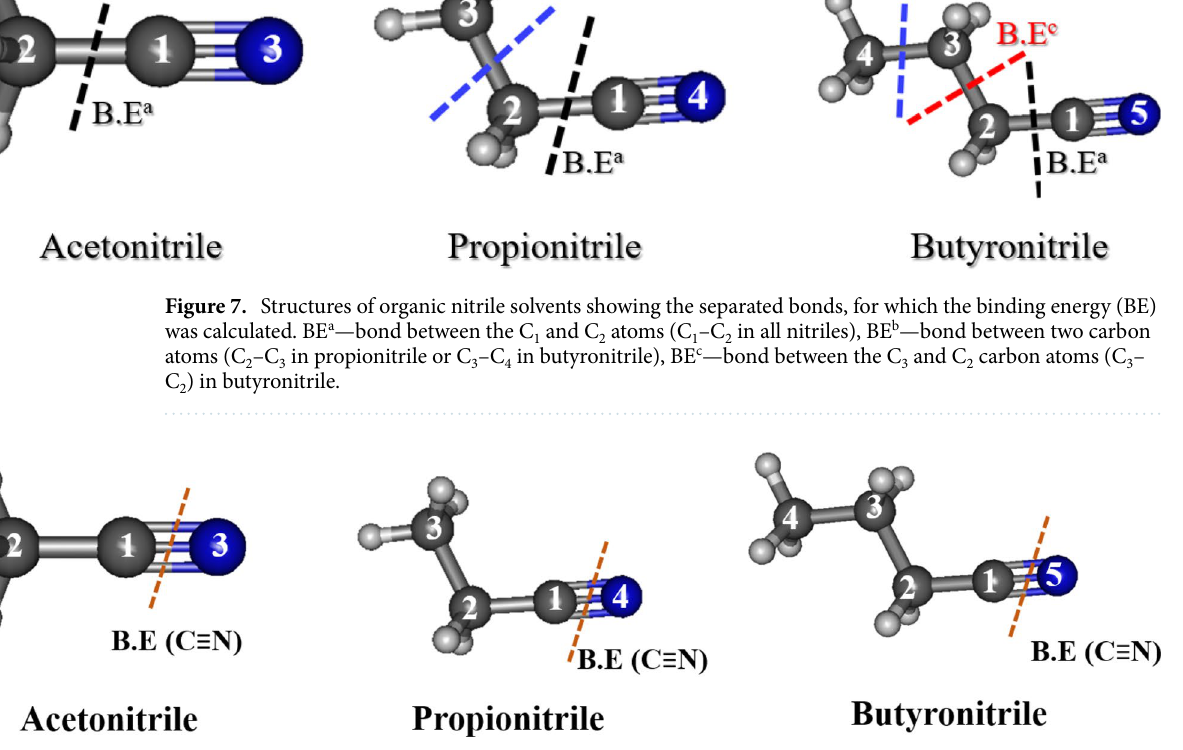
Figure 8. Structure of organic nitrile solvents showing the separated C ≡ N bonds, for which the binding energy was calculated.